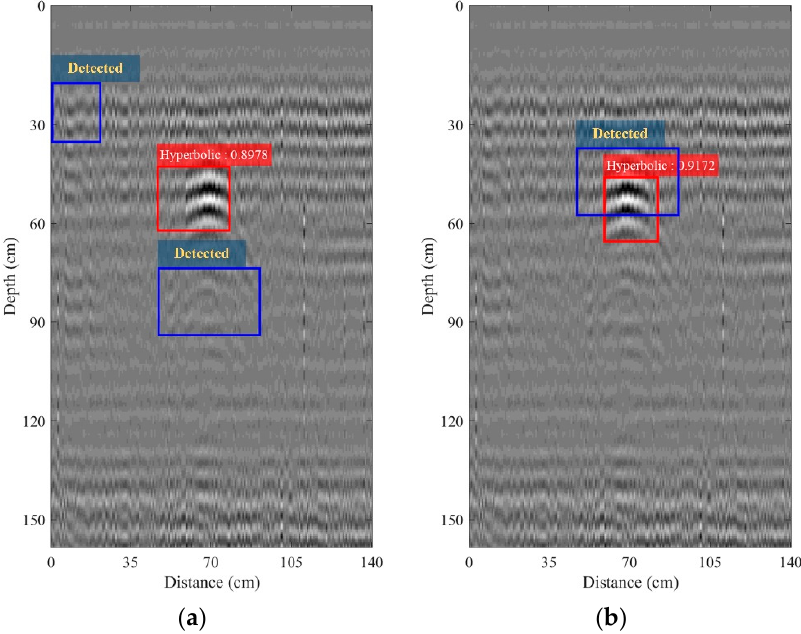
Figure 15. B-scan images collected by using the pickup truck-mounted GPR system on the road and obtained from performing the time-varying gain: ( a ) k = 0.05; ( b ) k =